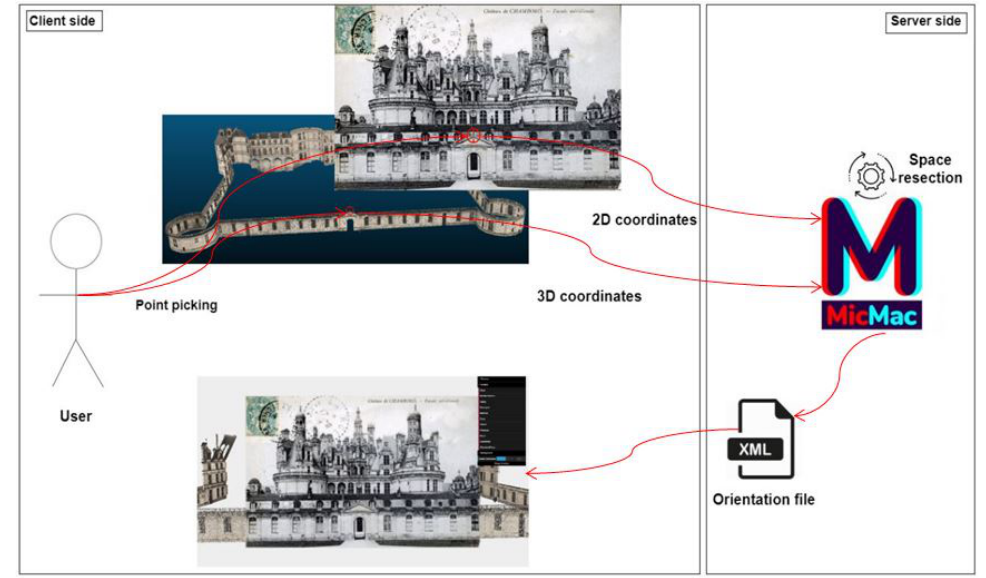
Figure 1. Client side of the application where the user interacts with the web interface and its connection with the server side where computations take